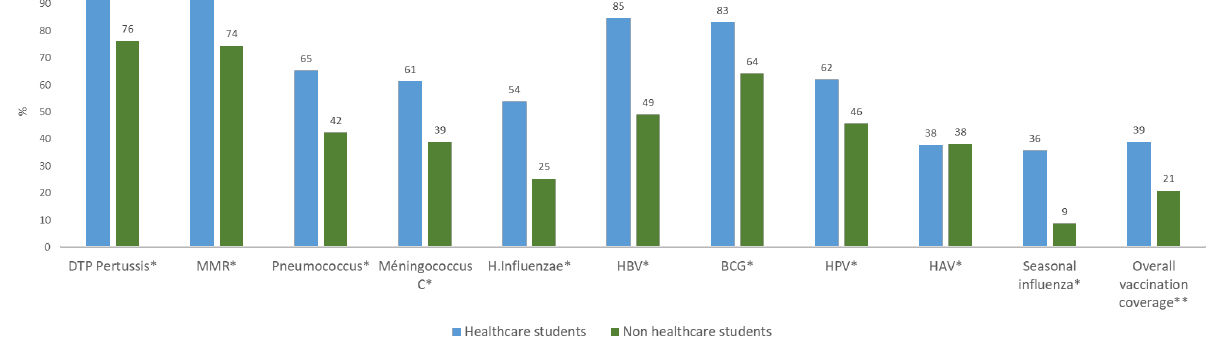
Figure 2. Vaccination coverage among university students in France ( n = 3089). * : p < 0.05. ** Overall VC: Vaccination with DTPcoq, MMR, HBV, meningococcus C, pneumococcus, Haemophilus.